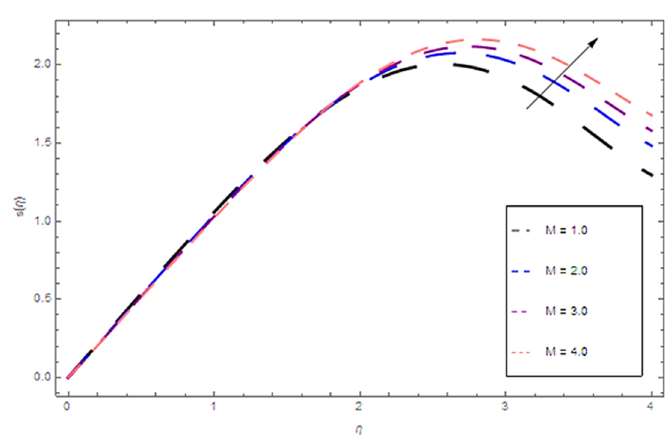
Figure 4. Impact of M on k ( η ) when k = 1.